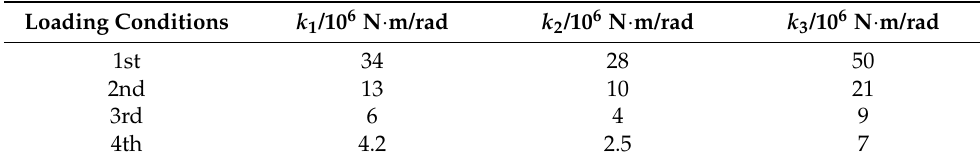
Table 3. Effective ratios of the transverse bending rigidity and thickness reduction coefficients under different loading